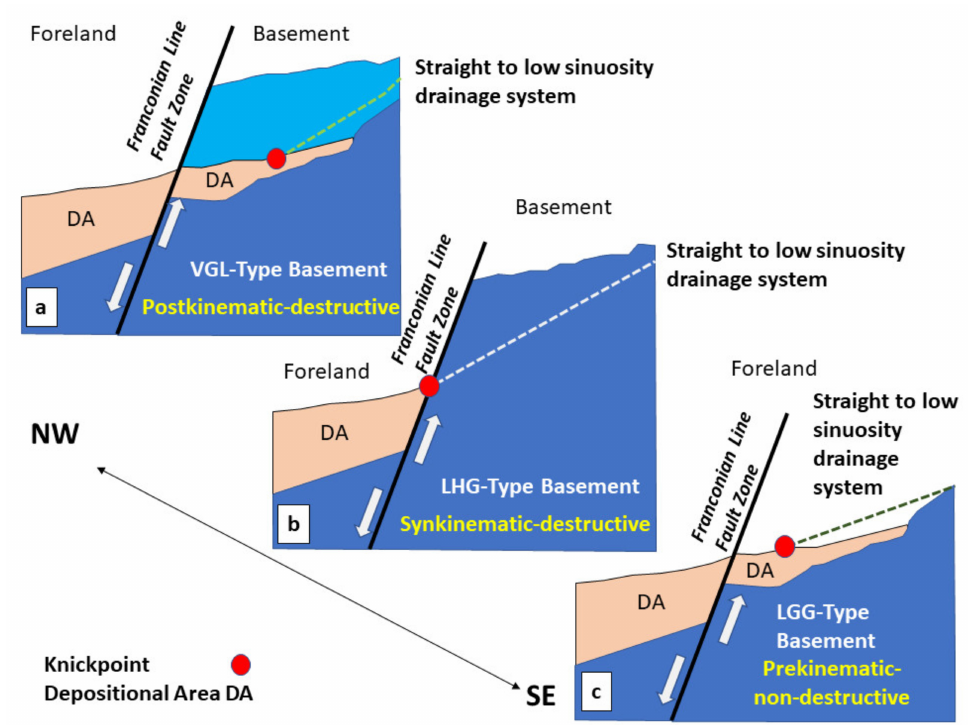
Figure 17. Cartoon to illustrate the relation between Cenozoic fault kinematic along the Franconian Line Fault Zone (FLFZ) and the evolution of the straight to low sinuosity drainage systems of the basement in the various reference sites from NW to SE. The 1st order knickpoint is indicated by the red dot. ( a ) VGL-Type; ( b ) LHG-Type; ( c )